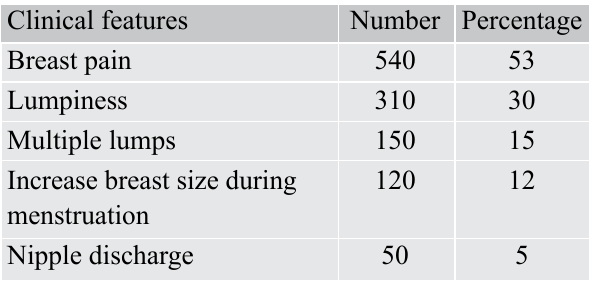
Table II: Distribution of subjects according to clinical